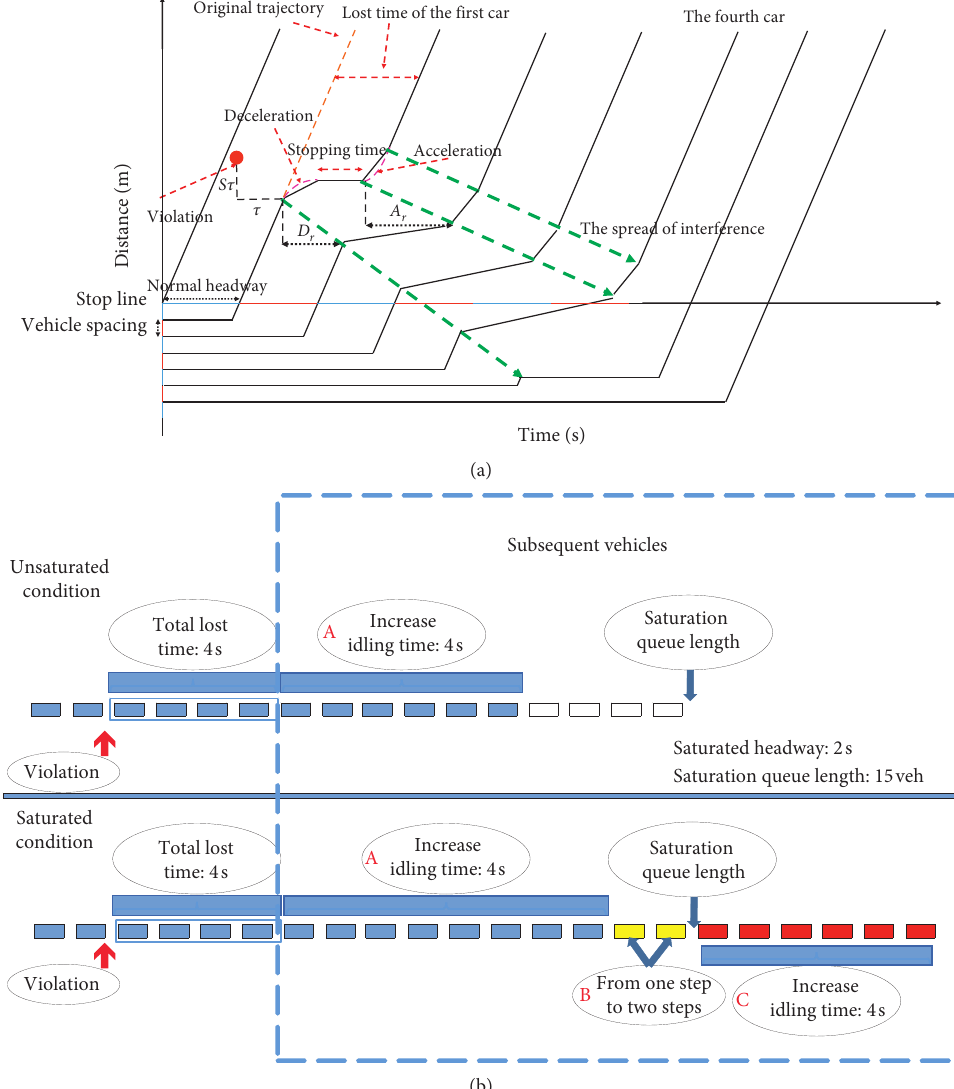
Figure 5: Vehicle characteristics affected by pedestrian and nonmotorized vehicle violations. (a) Trajectory level. (b) Traffic flow level.